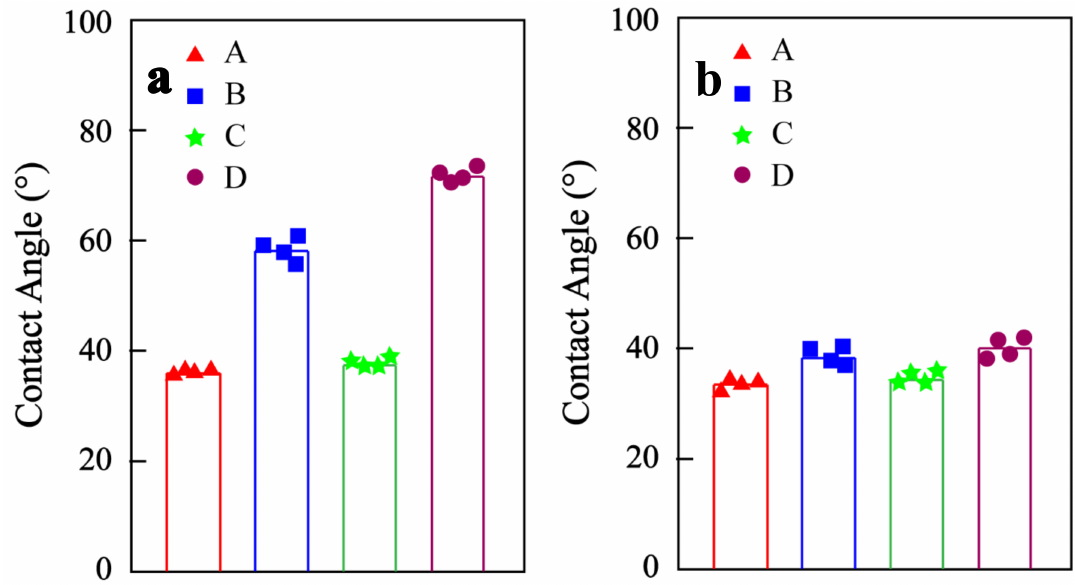
Figure 5. Effects of SPA and nanobubbles on the solid–liquid interface contact angle of rutile ( a ) and garnet ( b )